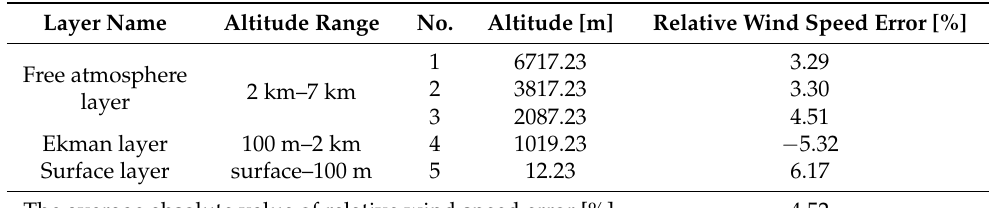
Table 5. Relative wind speed error between WRF and upper-atmosphere sounding data obtained in Hohhot at 12:00 LST on 26 September 2008.